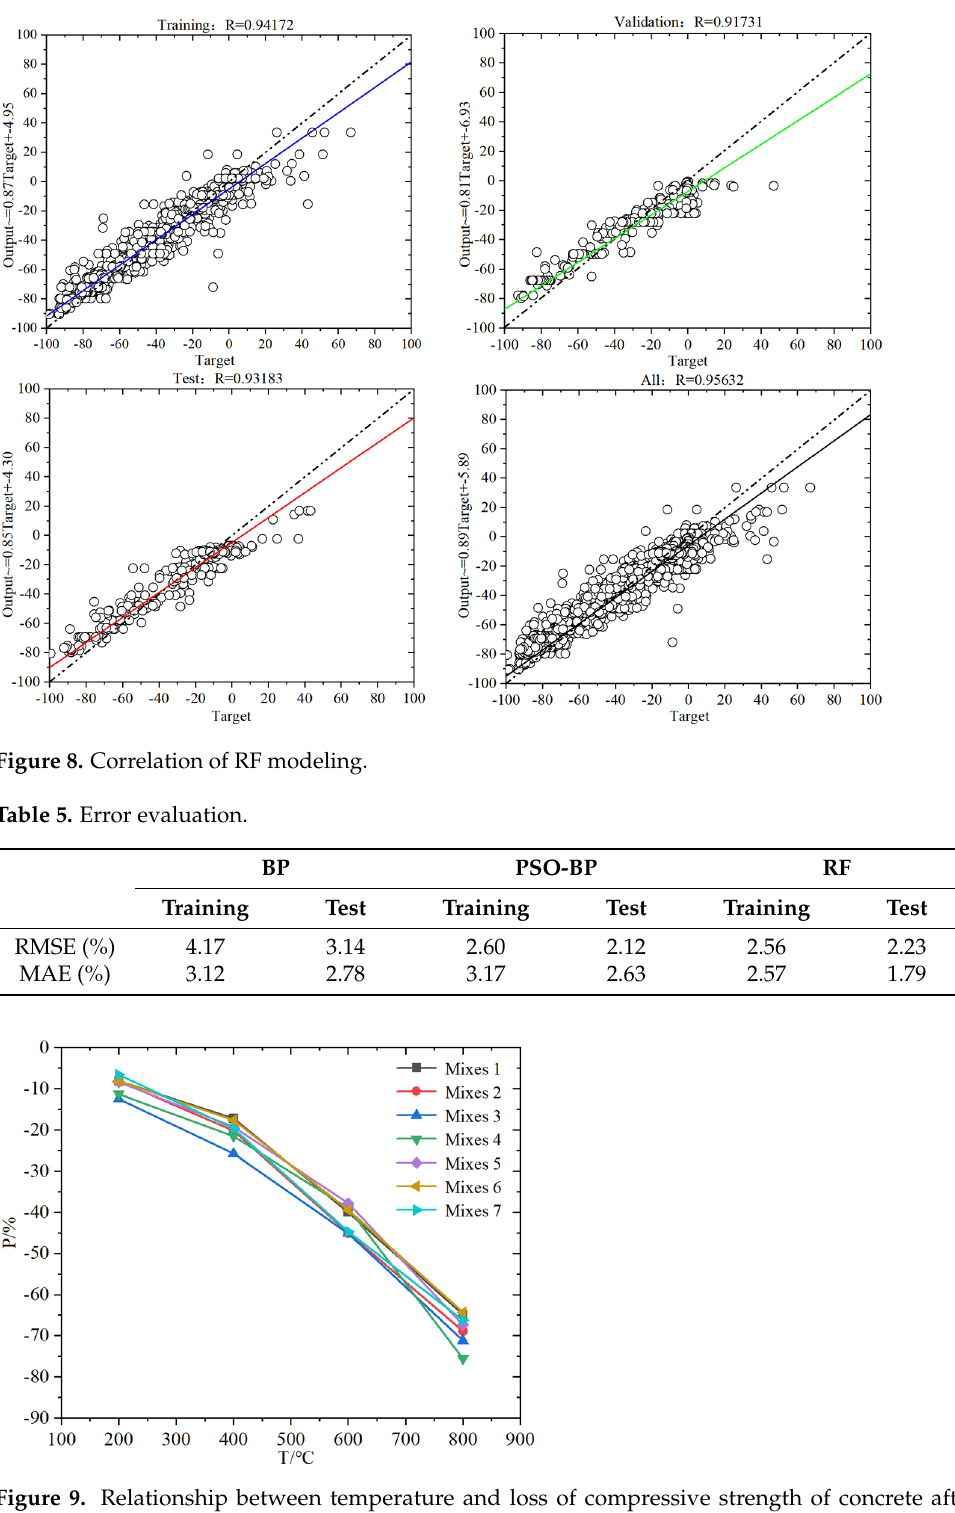
Figure 7. Correlation of PSO-BP modeling.